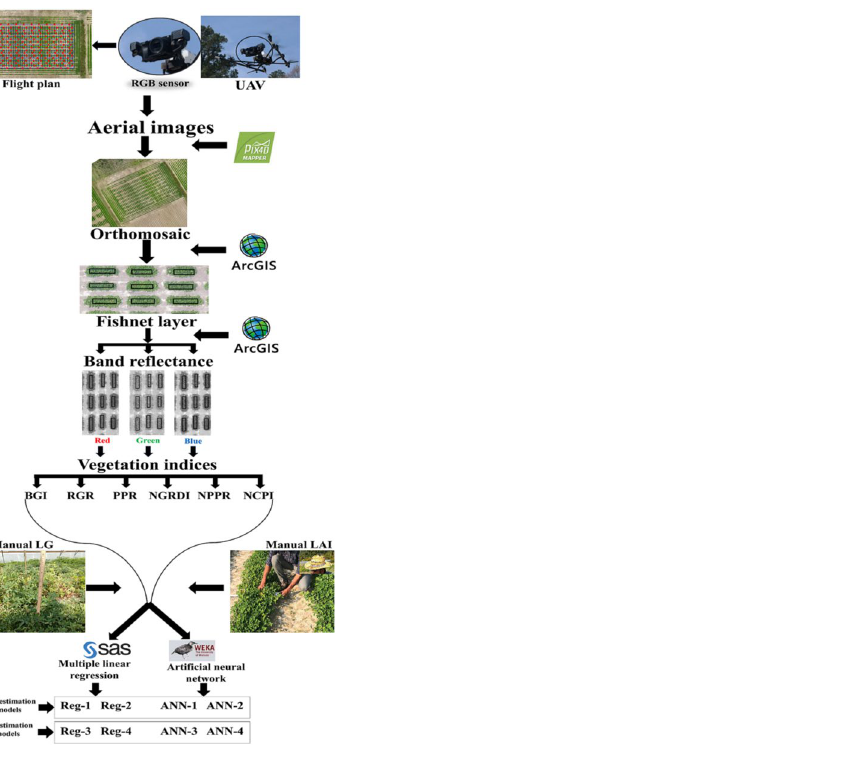
Figure 2. Flowchart of the process for aerial estimation of leaf area index (LAI) and lateral growth (LG). A RGB sensor is used to collect aerial images based on a flight plan. The aerial mages are used to recreate the whole experimental plot orthomosaic * . Rectangular shapes are created over peanut rows in a fishnet * layer. The fishnet is used to extract reflectance from each of the reg, green, and blue band. The reflectance are used to derive vegetation indices (VIs). The VIs are subjected to multiple linear regression and artificial neural network regression as predictors for LAI and LG. The different models derived in the process are Reg-1, Reg-2, ANN-1, and ANN-2 for LAI estimation; and Reg-3, Reg-4, ANN-3, and ANN-4 for LG estimation. *Orthomosaic was done using Pix4Dmapper Version 4.2.26 software (Prilly, Switzerland) and Fishnet was created using ArcMap (version 10.6) tool of the ArcGIS (ESRI, Redlands, CA).